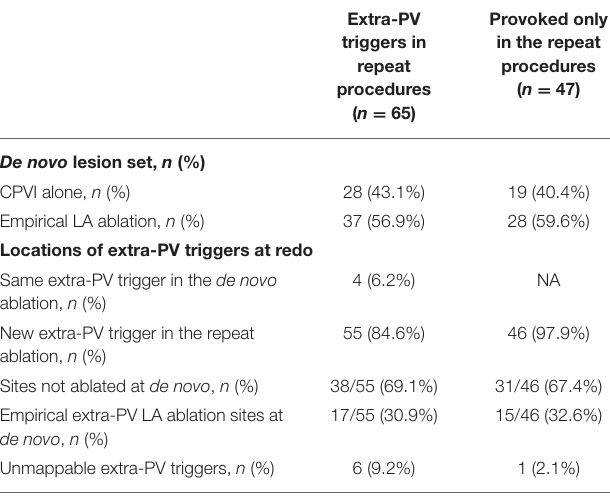
TABLE 3 | Characteristics of the extra-PV triggers provoked in repeat ablation